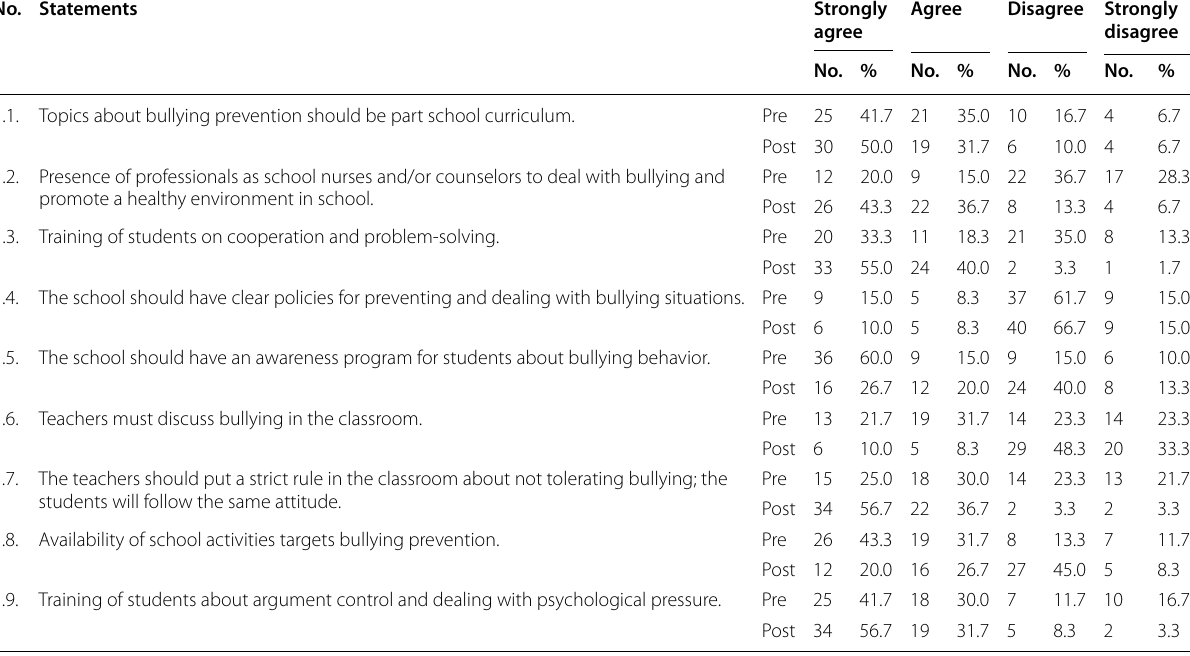
Table 3 Distribution of the studied subjects according to their bullying prevention pre and post a psychoeducational intervention ( n 60) =